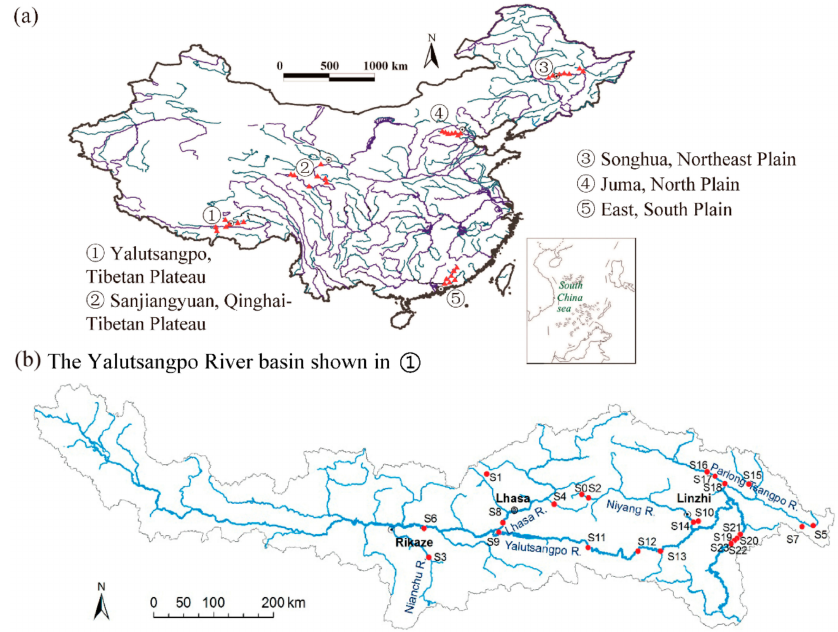
Figure 1. Study area and sampling sites: ( a ) sampling sites in the five selected rivers in different altitude regions; ( b ) sampling sites in the Yalutsangpo River